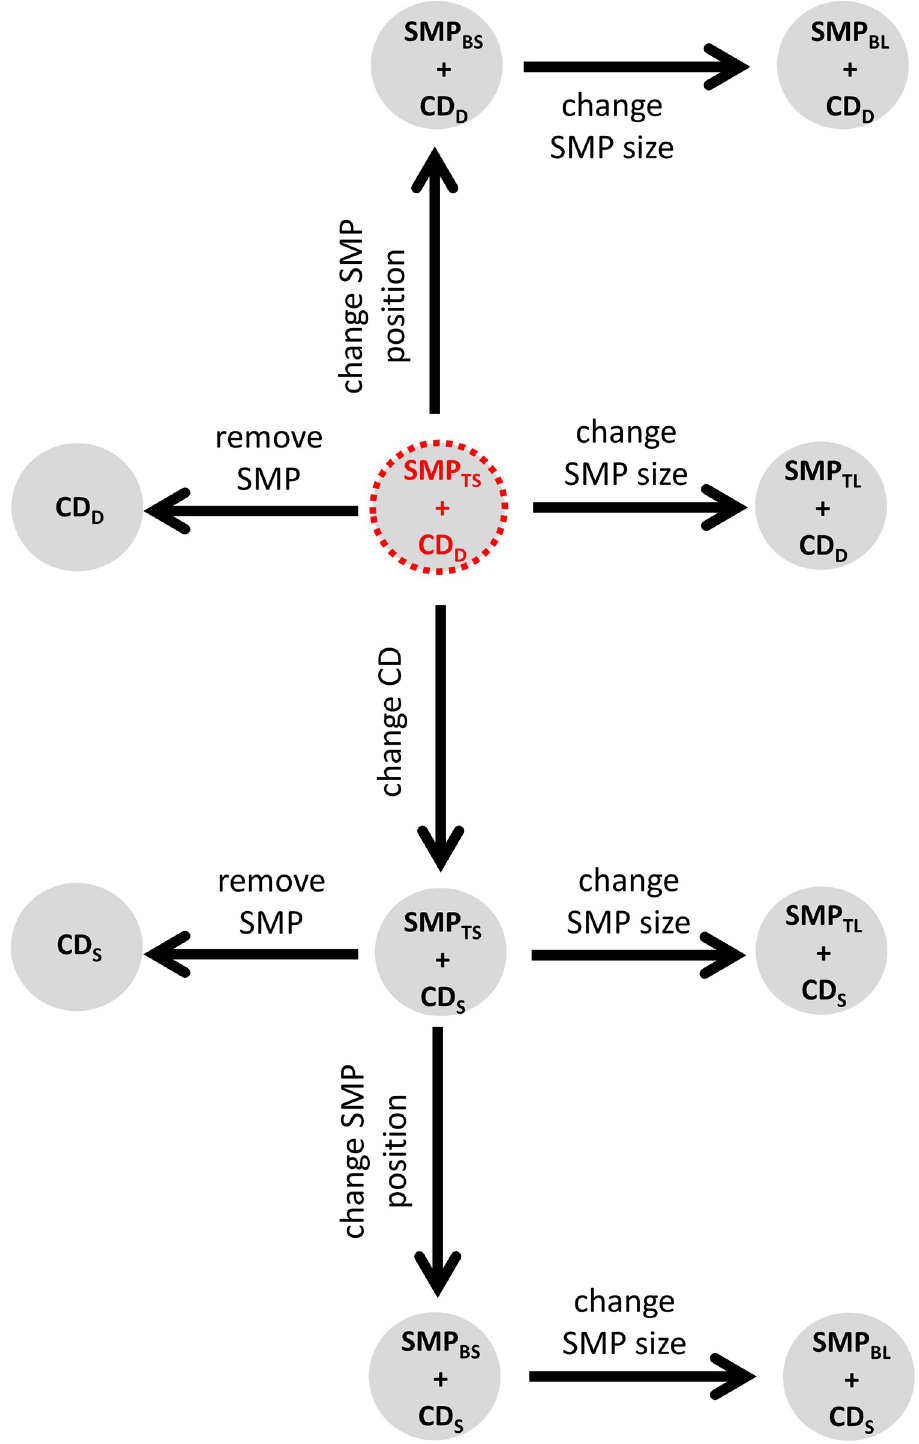
Fig 4. Treatment tree diagram. Arrows represent the delta comparisons carried out. Red circle indicates the reference gear design.